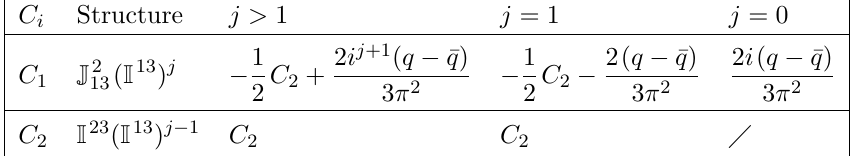
Table 3 . Ward identities of the R-current for the correlator